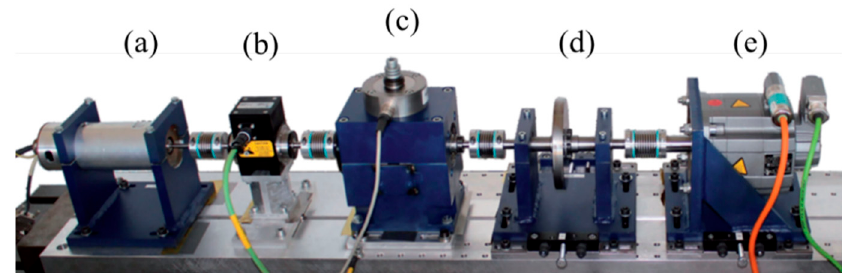
Figure 2. Modular test rig of PU dataset.